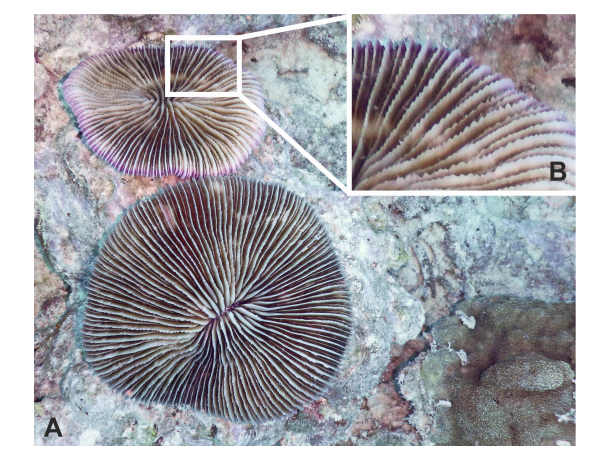
FIGURE 1 | (A) Two samples of Danafungia scruposa (Scleractinia, Fungiidae), each a solitary coral composed of a single polyp. (B) Recognizable serrated